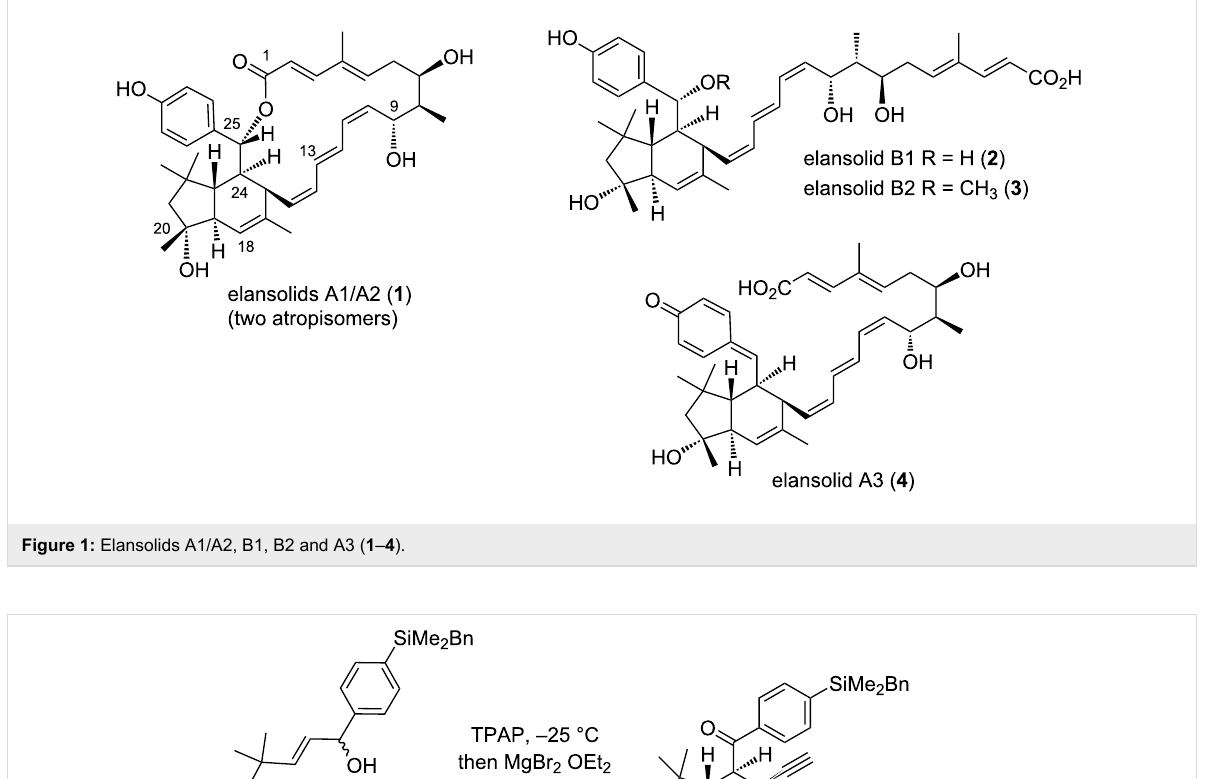
Figure 1: Elansolids A1/A2, B1, B2 and A3 ( 1 – 4 ).